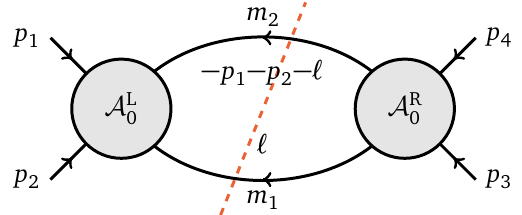
Figure 8: Conventions for the one-loop unitarity cut in the s